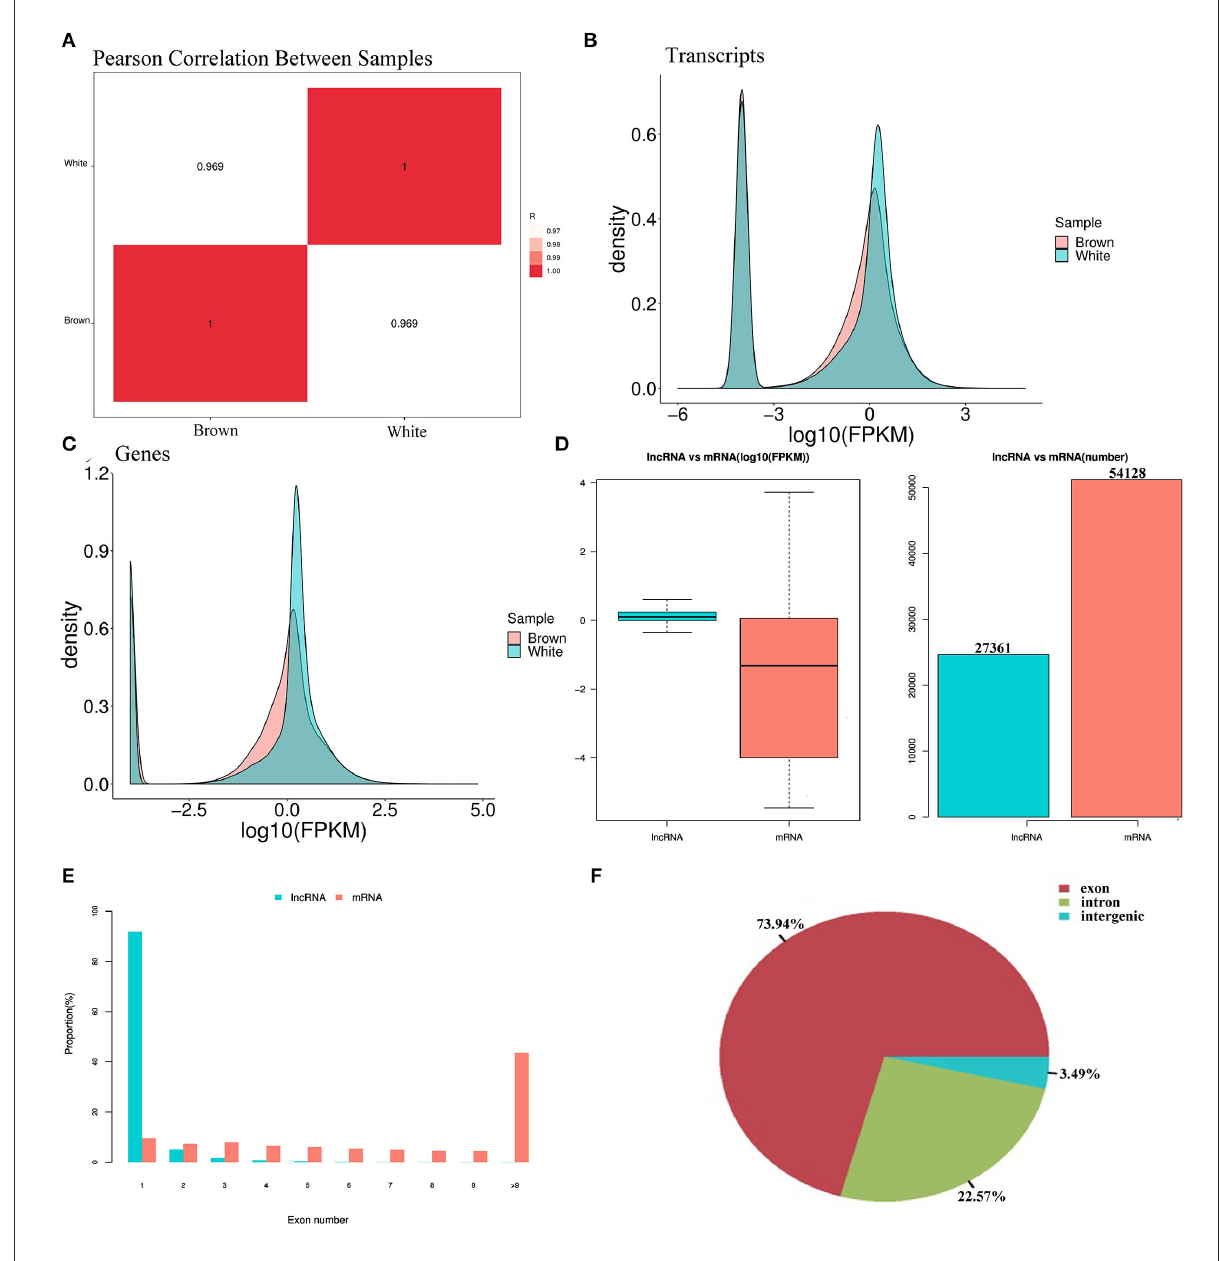
FIGURE3 Expression patterns of lncRNA and mRNA in melanocytes isolated from Boer goat skins with white and brown hairs. (A) Pearson’s correlation coefficient between different samples. (B,C) Expression value density of transcripts and gene expression trend. (D) Expression levels of lncRNAs and mRNAs in melanocytes. (E) Distribution of lncRNA and mRNA length in melanocytes. (F) Distribution of lncRNA located in